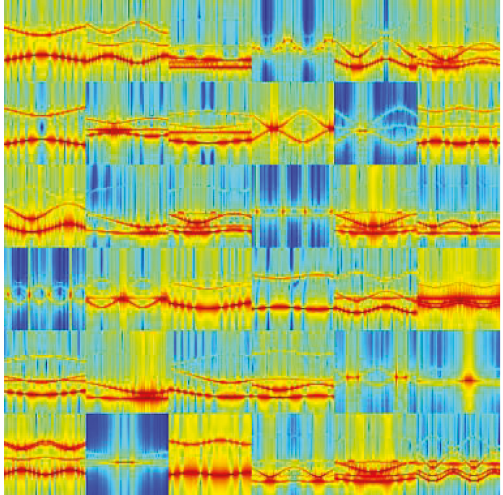
Figure 7: Random display of the time-range pro fi les in the training set.